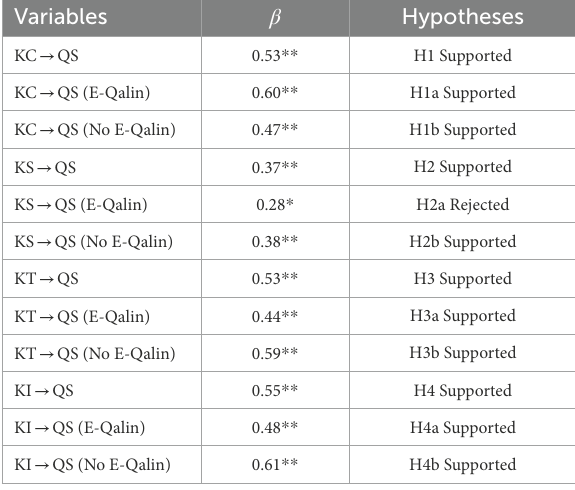
TABLE 3 Direct relationships between individual variable – linear regression.